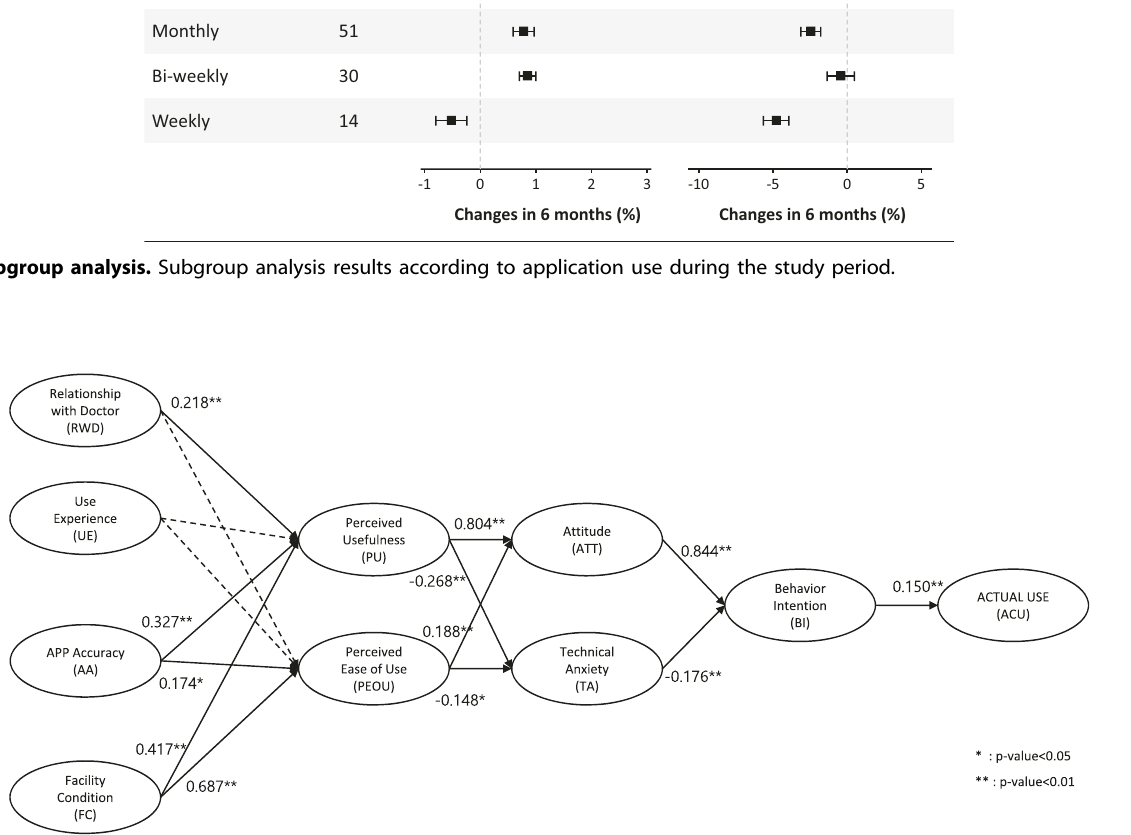
Fig. 3 Factors affecting the application use. Proposed structural equation model and path coef fi cients for persistent application